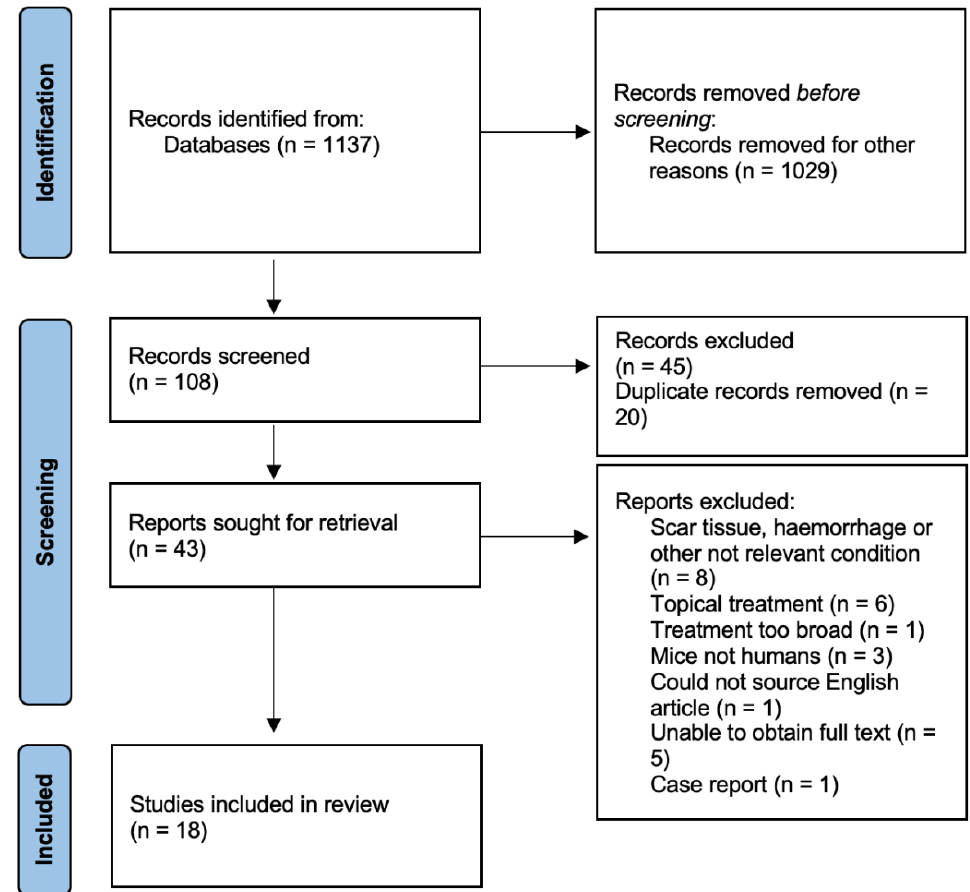
Figure 1. Identification of studies via databases.